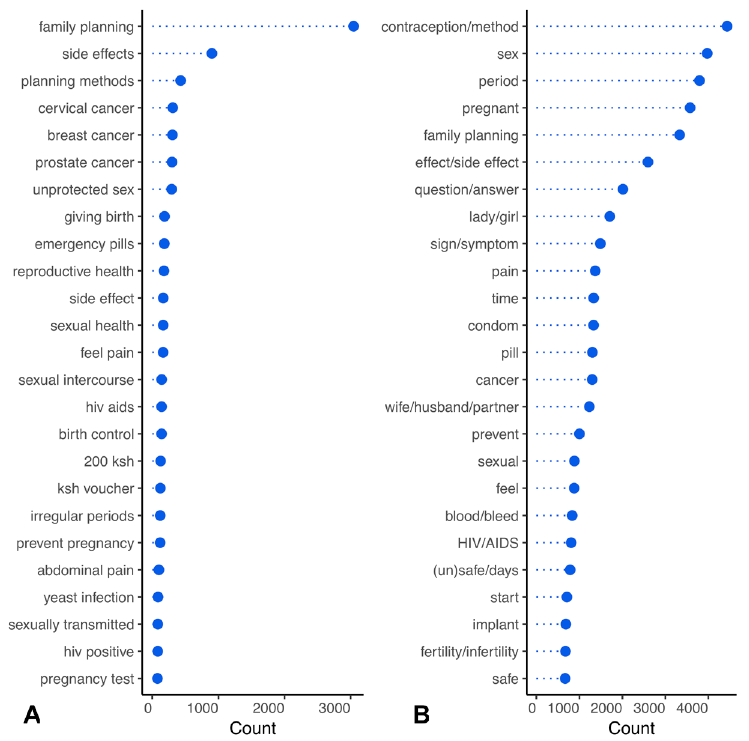
Figure 3. Most frequently occurring bigrams ( A ) and words ( B ) in incoming messages (English). ksh, Kenyan shillings; HIV, human immunodeficiency virus; AIDS, acquired immunodeficiency syndrome.